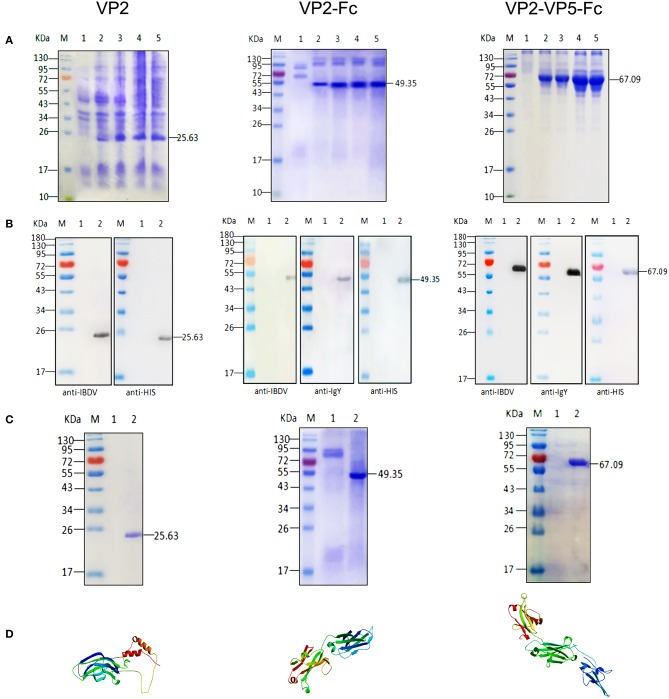
Expression, SDS–PAGE identification, and Western blot analysis of the recombinant proteins. (A) SDS–PAGE identification of the recombinant VP2, VP2–Fc, VP2–VP5–Fc at different induction times. M, Page ruler pre–stained protein ladder; lane 1, culture supernatant of P. pastoris transformed with blank pPIC9 vector (negative control); lanes 2–5, culture supernatant of P. pastoris transformed with the recombinant plasmids after 24, 48, 72, and 96 h of methanol induction. (B) Western blot identification of the recombinant proteins with the mouse anti–IBDV polyclonal antibody, the rabbit anti–chicken IgY and anti–His tag antibody. M, protein molecular size page ruler; lane 1, culture supernatant of P. pastoris transformed with blank pPIC9 vector (negative control); lane 2, culture supernatant of P. pastoris transformed with the recombinant plasmids at 96 h post induction. (C) Purification of the fused VP2. M, Page ruler pre–stained protein ladder; lane 1, culture supernatant after column chromatography; lane 2, purified VP2. (D) 3D structure of the recombinant proteins.